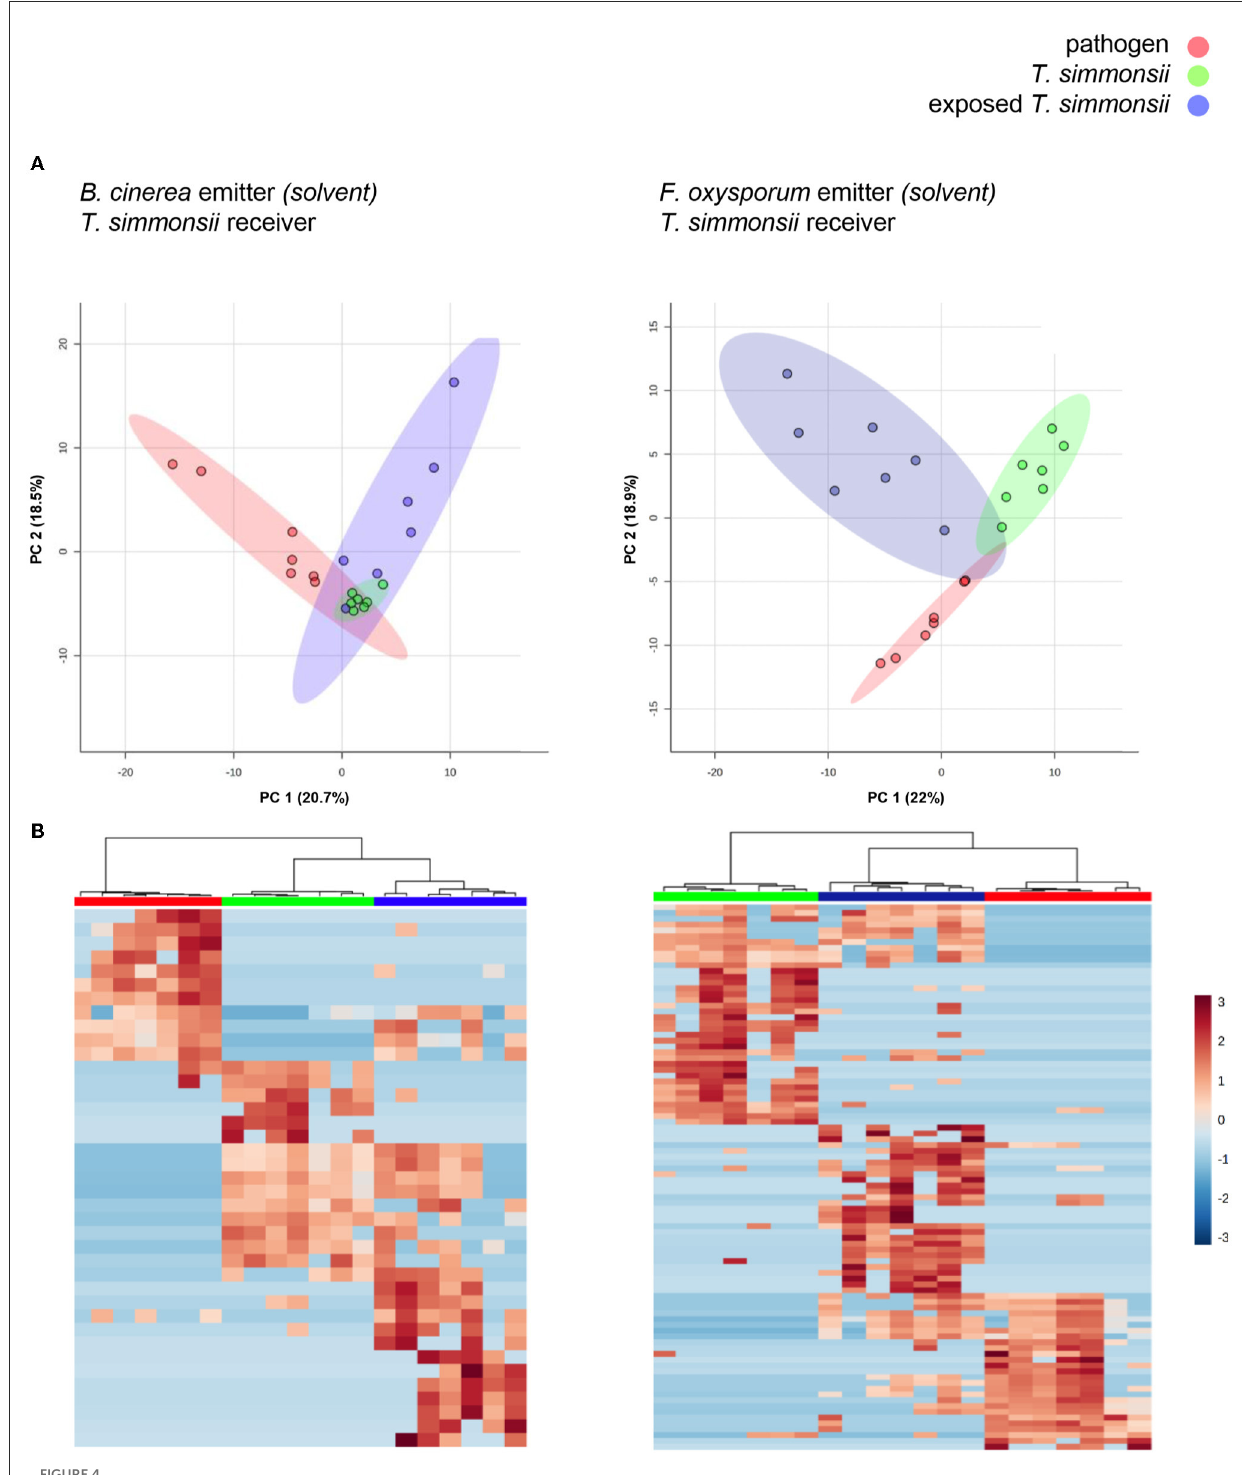
FIGURE4 Differences in volatilome profiles between Trichoderma grown alone or exposed to the volatilomes of either Botrytis or Fusarium dissolved in methanol (single microcosm setup). (A) Principal Component Analysis (PCA) plots of volatilome profiles; each dot represents one volatilome sample and each circle represents the 95% confidence interval. (B) Heatmap representing the hierarchical clustering of volatiles with significantly different abundances between the different groups. Each line represents a mass feature (volatile compound) and each column represents a sample. The color indicates the normalized intensity of the respective volatiles and the dendrograms display the similarity based on the Pearson algorithm. Volatilomes from Trichoderma originate from mycelial cultures grown either with or without exposure to the volatiles from Botrytis or Fusarium , while the volatilomes from both phytopathogens originate from microcosms containing previously collected volatiles resuspended in solvent (see material and methods for more